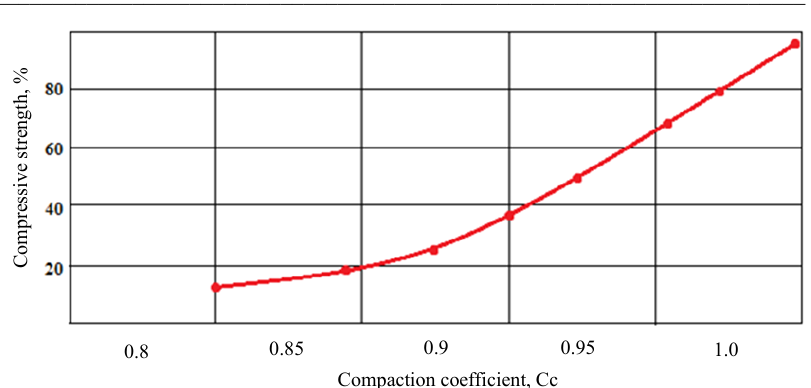
Fig. 3. Influence of the degree of compaction (Сс) of concrete on its frost resistance (F)